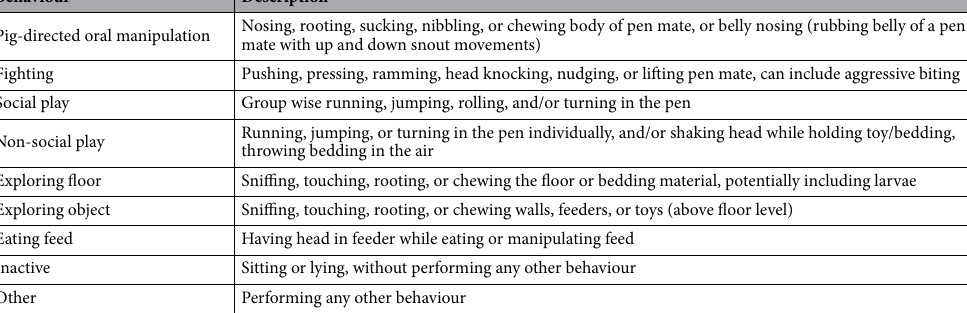
Table 1. Ethogram of behaviours observed in the home